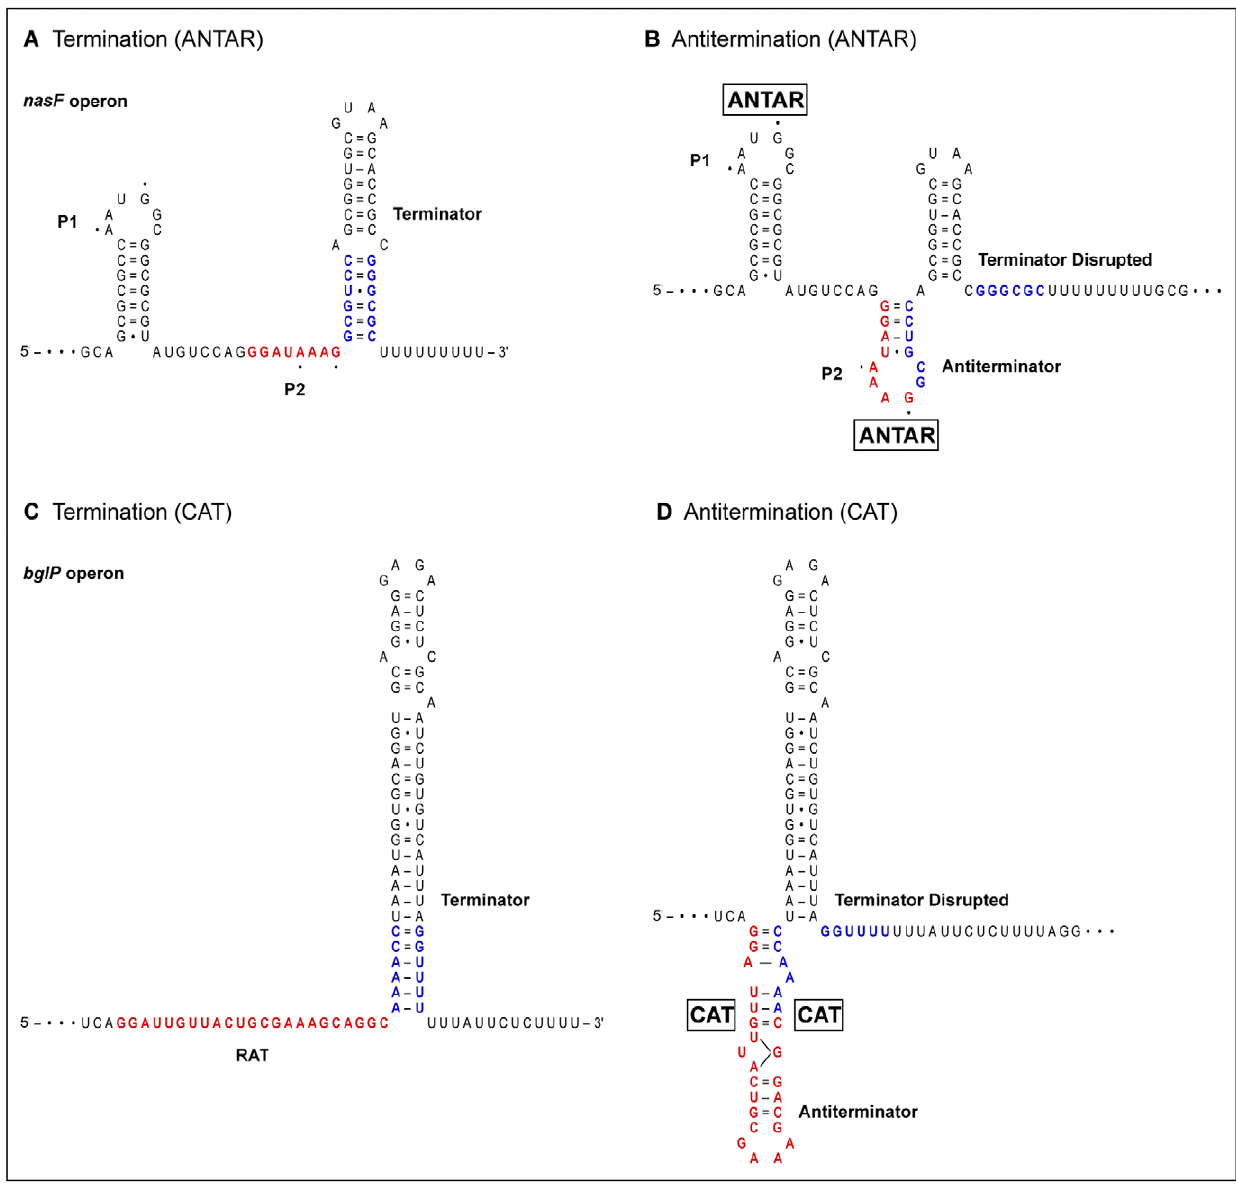
Figure 1. RNA-binding proteins stabilize antiterminator structures. Alternative stem-loop structures in transcribed leader regions from representative operons are shown. Terminator stem regions that participate in alternative structures are in blue, whereas antiterminator regions are in red. (A) NasR-responsive nasF operon leader in termination conformation. Dots indicate the critical residues A1 and G4 in the P1 and P2 loops. (B) Each ANTAR monomer is hypothesized to bind one of the loops, P1 and P2. Stabilizing the P2 antiterminator structure permits transcription readthrough [6] by shortening the terminator stem and separating it from the poly-U tract [2]. (C) LicT-responsive bglP operon leader in termination conformation. RAT is the ribonucleic antiterminator. (D) Each CAT (co-antiterminator) monomer binds to the antiterminator stem. Unusual base- pairing within the antiterminator stem is depicted schematically [25]. Stablilizing the antiterminator structure permits transcription readthrough [22] by shortening the terminator stem and separating it from the poly-U